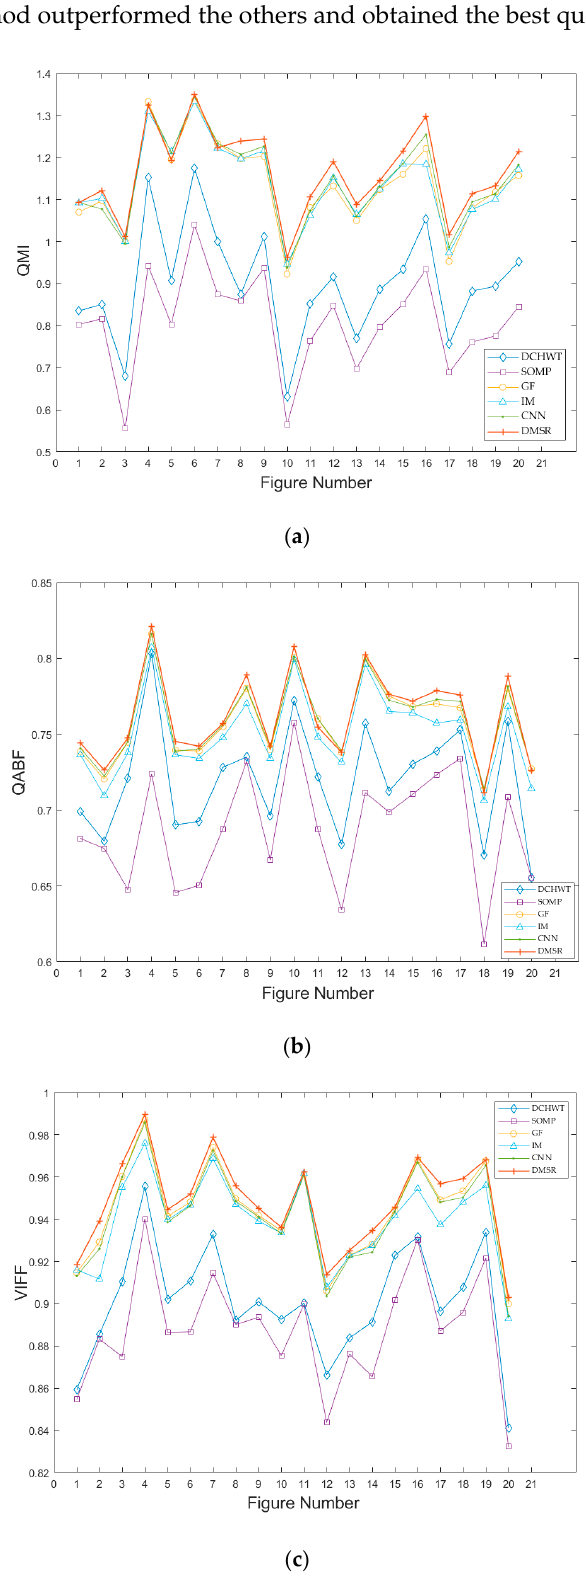
Figure 13. Quantitative assessment line charts of different image fusion methods for Lytro image dataset: ( a ) Q MI ; ( b ) Q AB / F ; ( c ) visual information fidelity for fusion ( VIFF